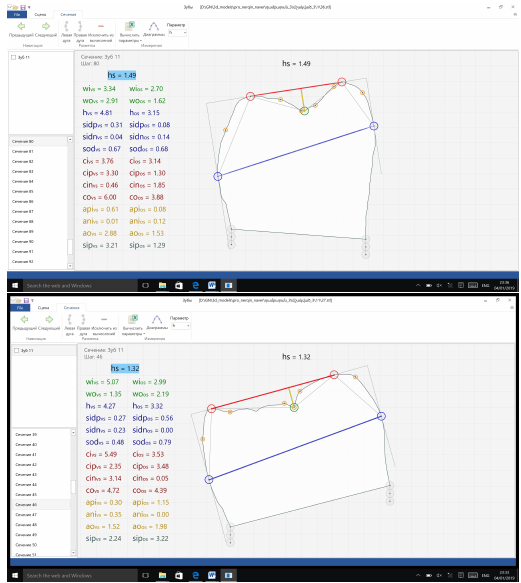
Figure 9. Variety in tilts of planes on contours of